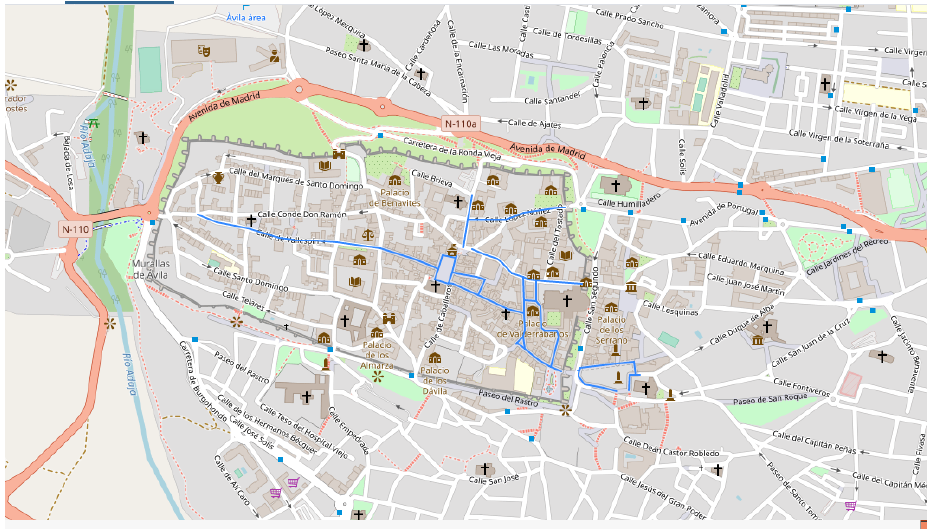
Figure 5. Top commercial business streets of the